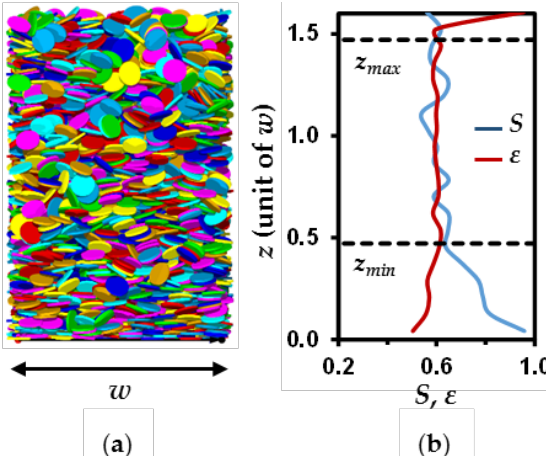
Figure 1. Analysis of porosity and anisotropy in simulated disk packings. ( a ) Three-dimensional packing and ( b ) associated porosity ε and order parameter S along the z direction. The overall porosity and S values for the packings are calculated from the nearly homogeneous part of the profiles between z min and z max .